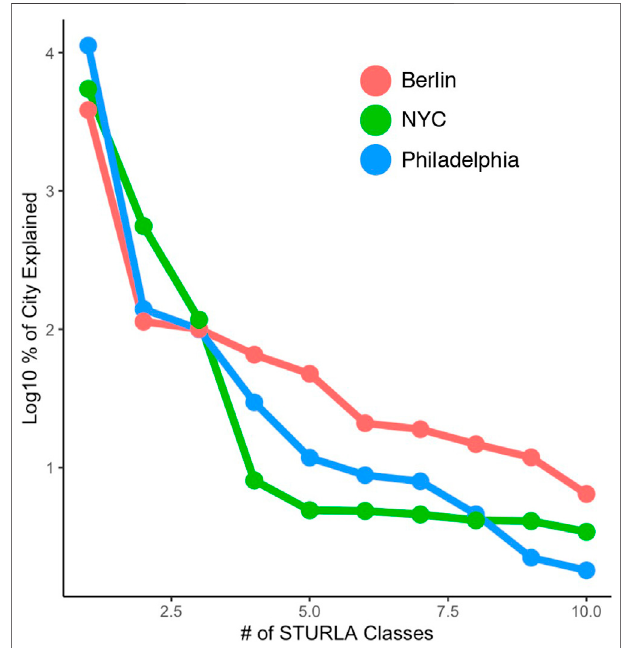
FIGURE 2 | Ranked distribution plot of STURLA class frequency by log 10 class abundance for each